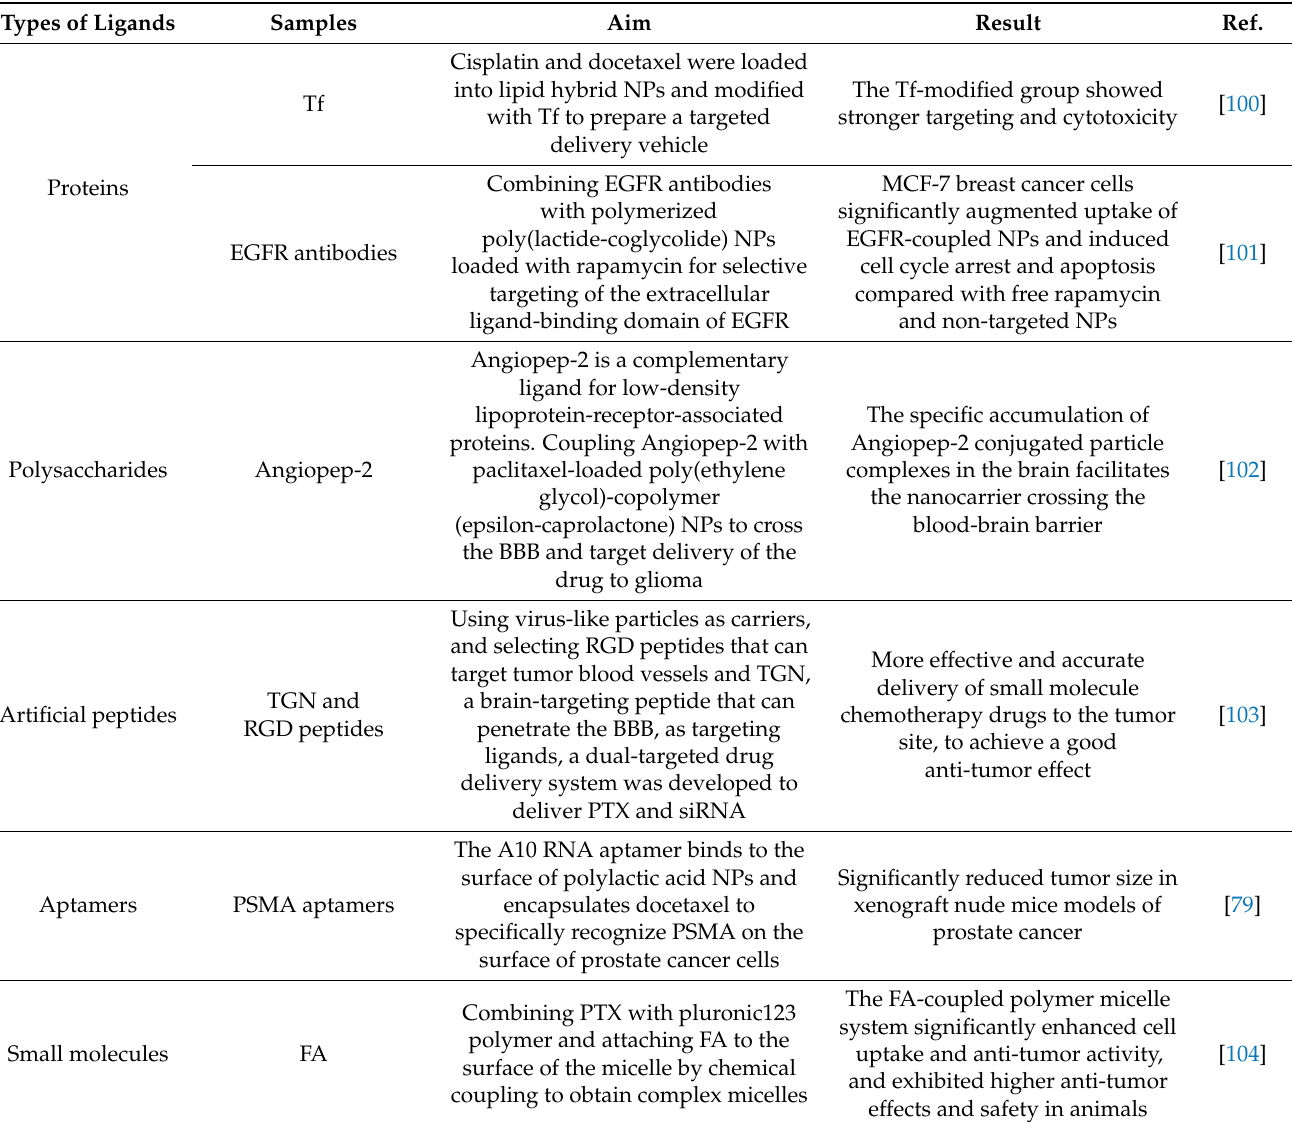
Table 1. List of some tumor treatments based on ligand-receptor